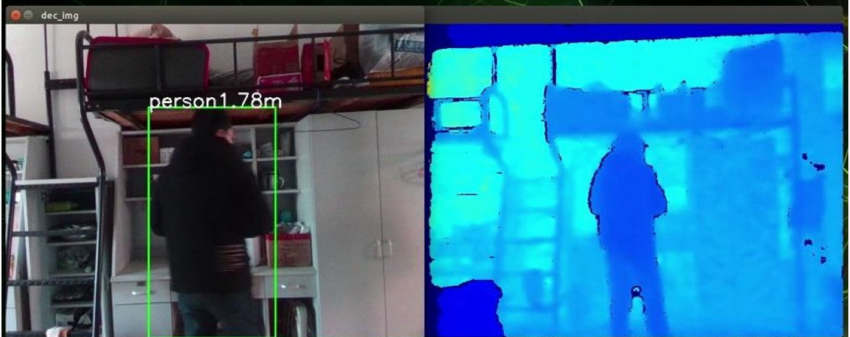
Figure 10. The real-time performance test for object detection on the NVIDIA Jetson NX embedded platform. The YZNet-YOLOV5-tiny system can simultaneously capture the target category with the distance provided by the depth image from the D435i camera. The complete video is available at: https://www.bilibili.com/video/BV1G44y1J76B?share_source=copy_web (19 December 2021).